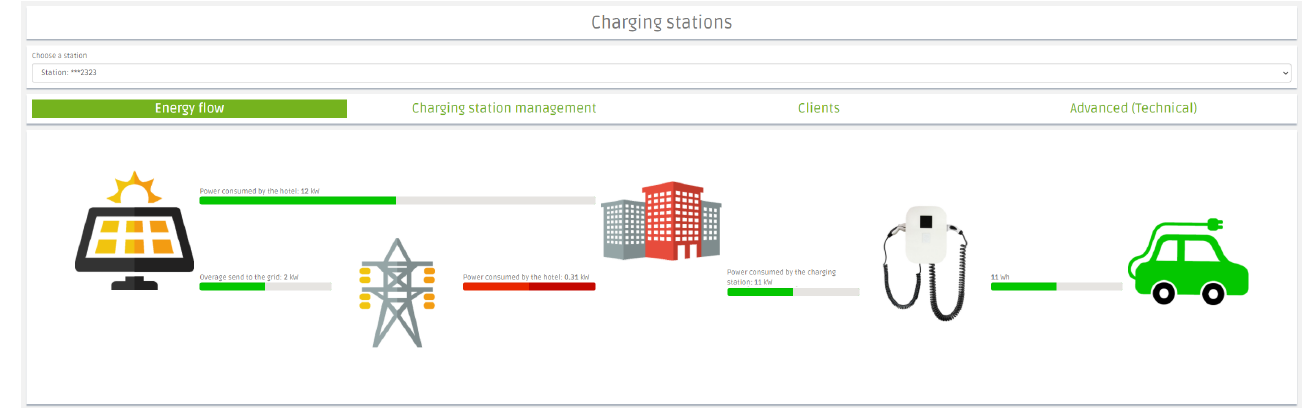
Figure 7. Energy flow tab on the web interface.